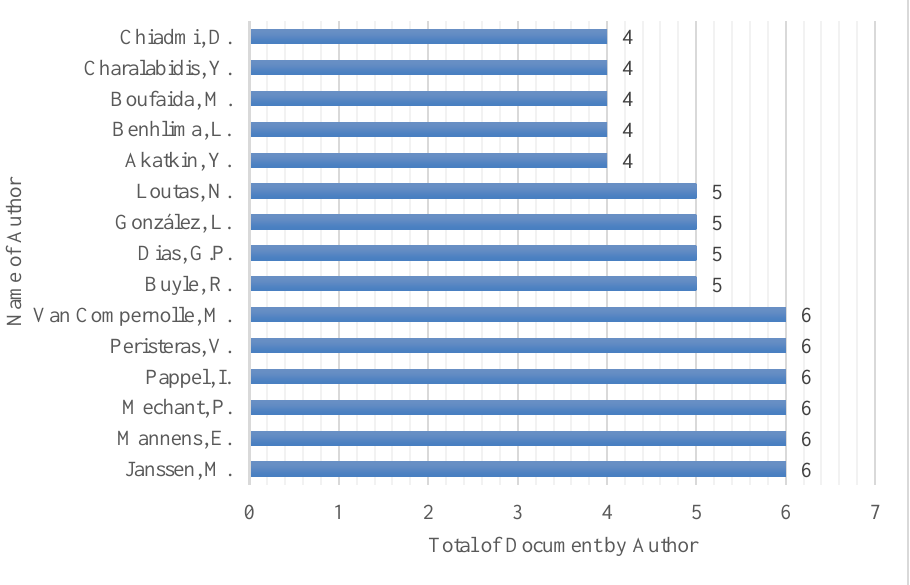
Figure 3: Publication by Authors. Source: Scopus database.